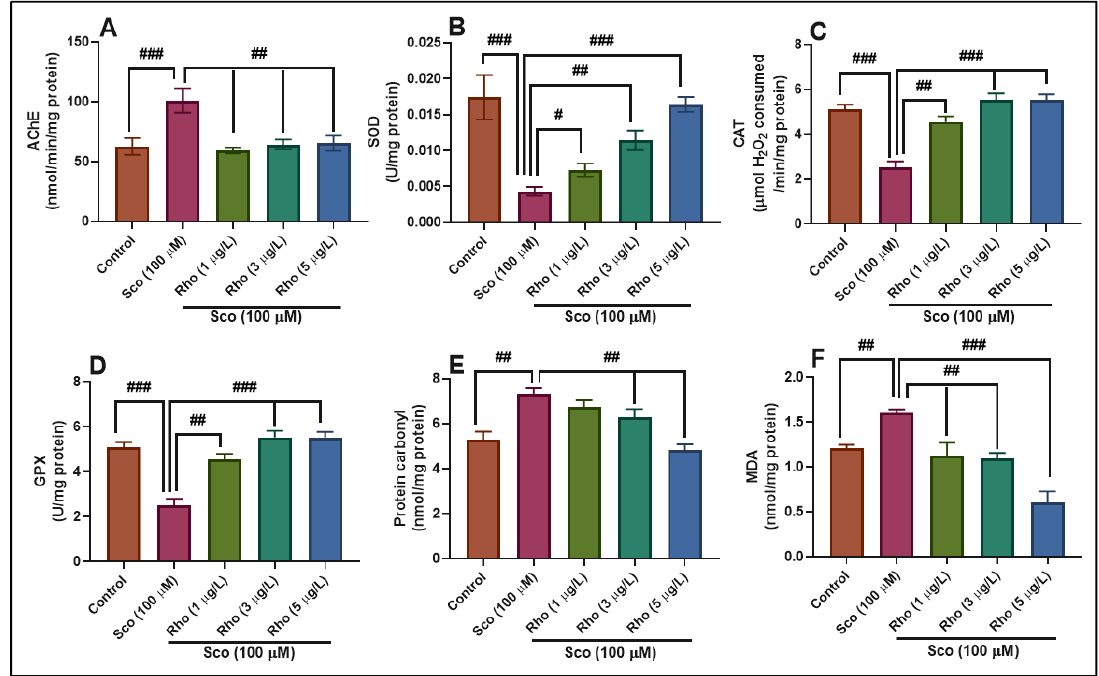
Figure 5. Rhoifolin (Rho: 1, 3, and 5 µ g / L) exhibited an anti-AChE e ff ect and improved the antioxidant status in the zebrafish brain. ( A – D ) Representation of the enzymes’ specific activity (AChE, SOD, CAT, and GPX) in di ff erent groups; ( E , F ) Representation of the protein carbonyl and MDA levels in di ff erent groups. Values are means ± S.E.M. (n = 10). For Tukey’s post hoc analyses: ( A ) Control vs. Sco